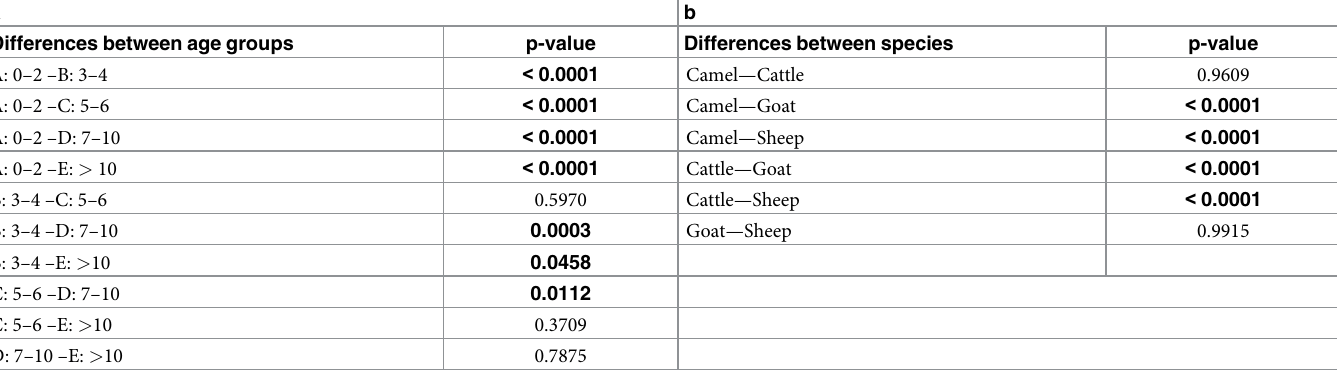
Table 4. Results of the generalized linear mixed-effects model (GLMM) for age (a) and species (b) after p-value adjustment using multivariate t-distribution. The significance level was set to 0.05. Significant results were marked in bold. a b Differences between age